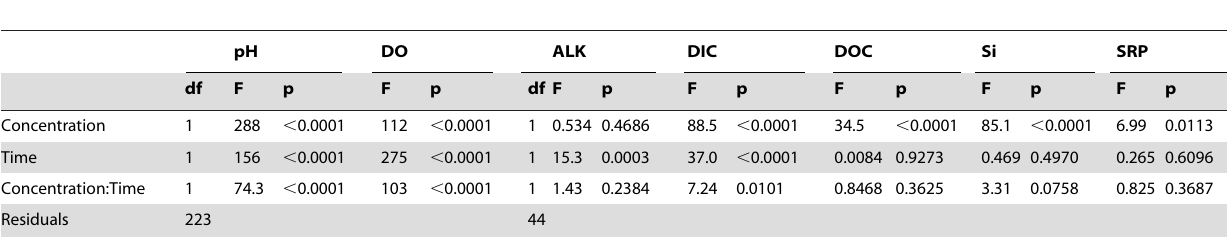
Table 4. The effects of time of sampling (morning vs. afternoon) and treatment factors (algal water concentrations on water chemistry in the laboratory